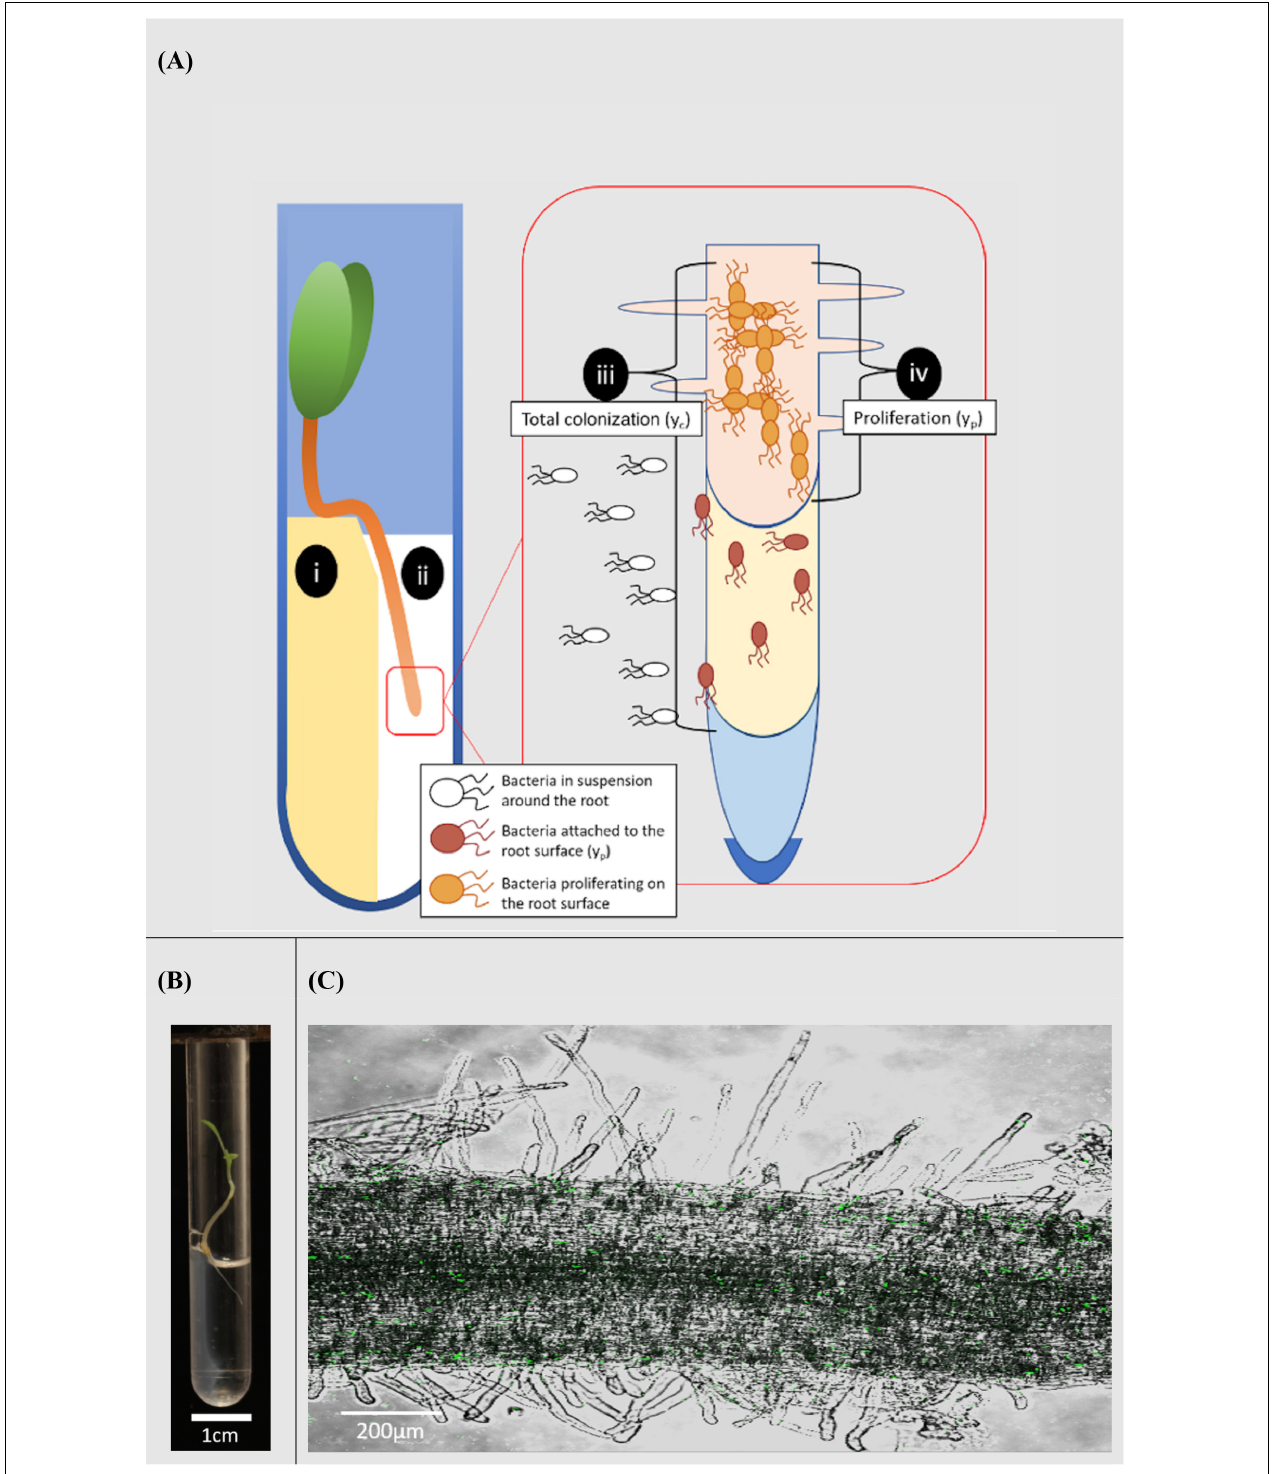
FIGURE 1 | Microcosm system for the study of rhizoplane colonization. (A) Diagram of the microcosm system; (i) plants are grown on a water agar slope. (ii) A bacterial suspension is introduced to a level no higher than the hypocotyl. The system allows bacterial movement along the root and quantification of the colonization process; (iii) total colonization (y c ) was the result of both attachment to and proliferation on the root surface. (iv) Proliferation on the root surface (y p ) was quantified in the absence of attachment. (B) Microcosm chamber containing a growing lettuce seedling. (C) A confocal image of Pseudomonas fluorescens SBW25 E1433 (shown in green) superimposed over a brightfield image of a lettuce